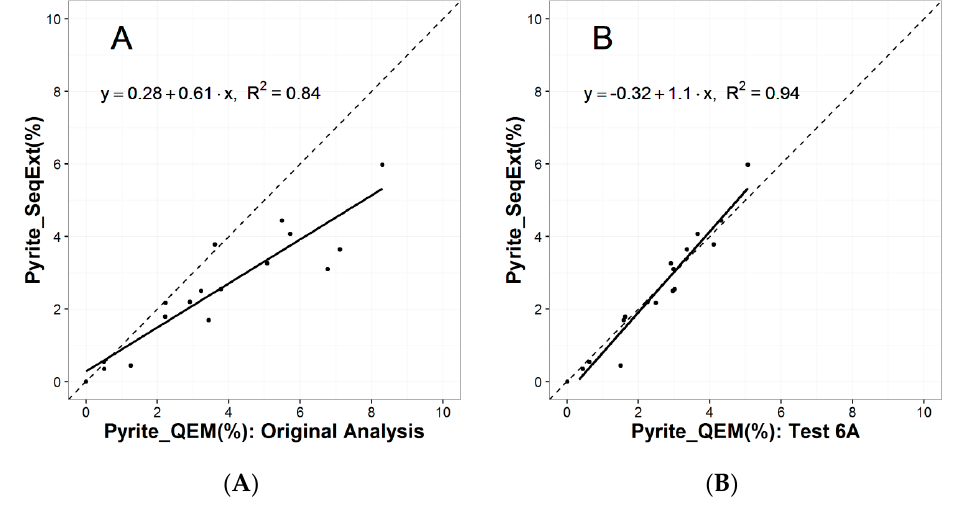
Figure 8. ( A ) Conciliation for pyrite using eighteen samples. Comparison is for pyrite percentages calculated with sequential extraction results vs. the original QEMSCAN ® results from 2008 and ( B ) the results obtained for the polished section prepared using the methodology from Test 6A, which involved sample particle size reduction and preparation of a transverse polished section.